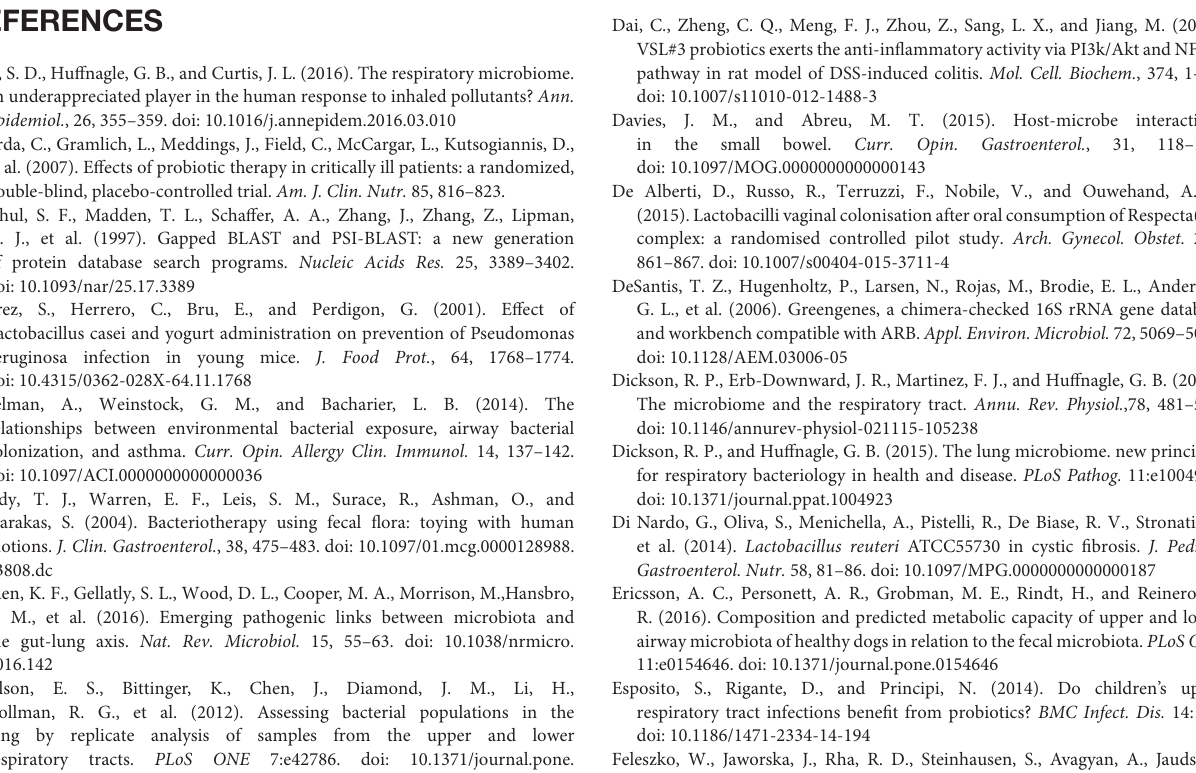
Supplementary Figure 1 | β -diversity as shown via principal coordinate analysis of Bray-Curtis distances between samples from all four sample sites (rectal swab, OP swab, BALF, and blood); legend at right.